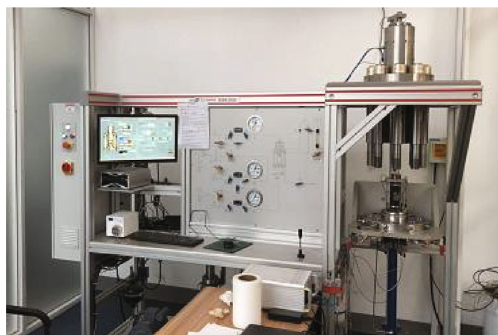
Figure 3: ROCK600-50 testing system.